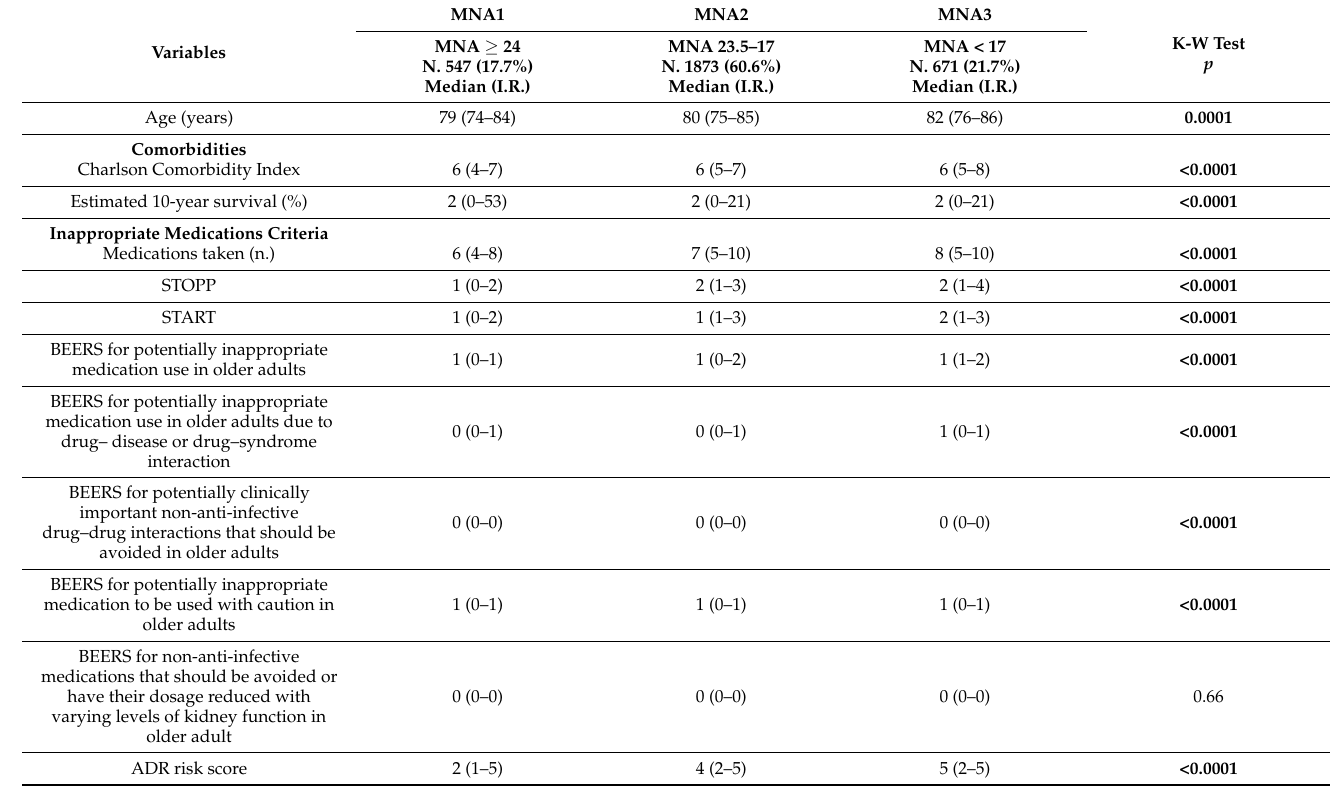
Table 3. Kruskal–Wallis and MNA: comparison between well-nourished, at risk of malnutrition, and malnourished